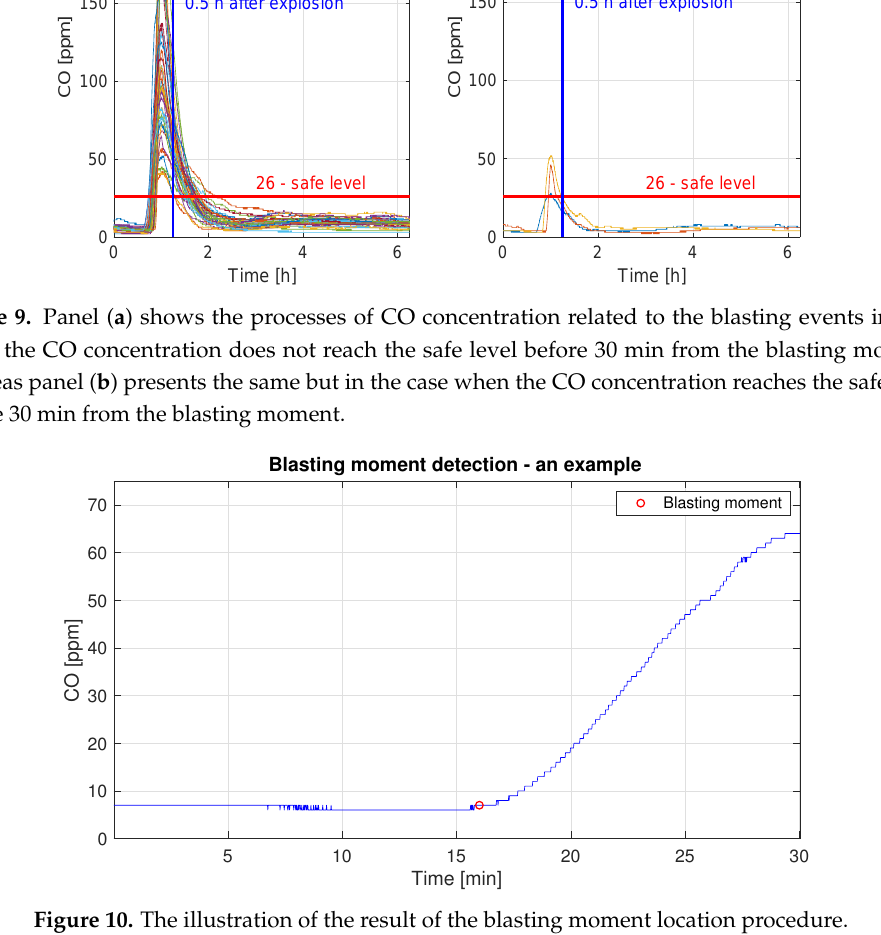
Figure 10. The illustration of the result of the blasting moment location